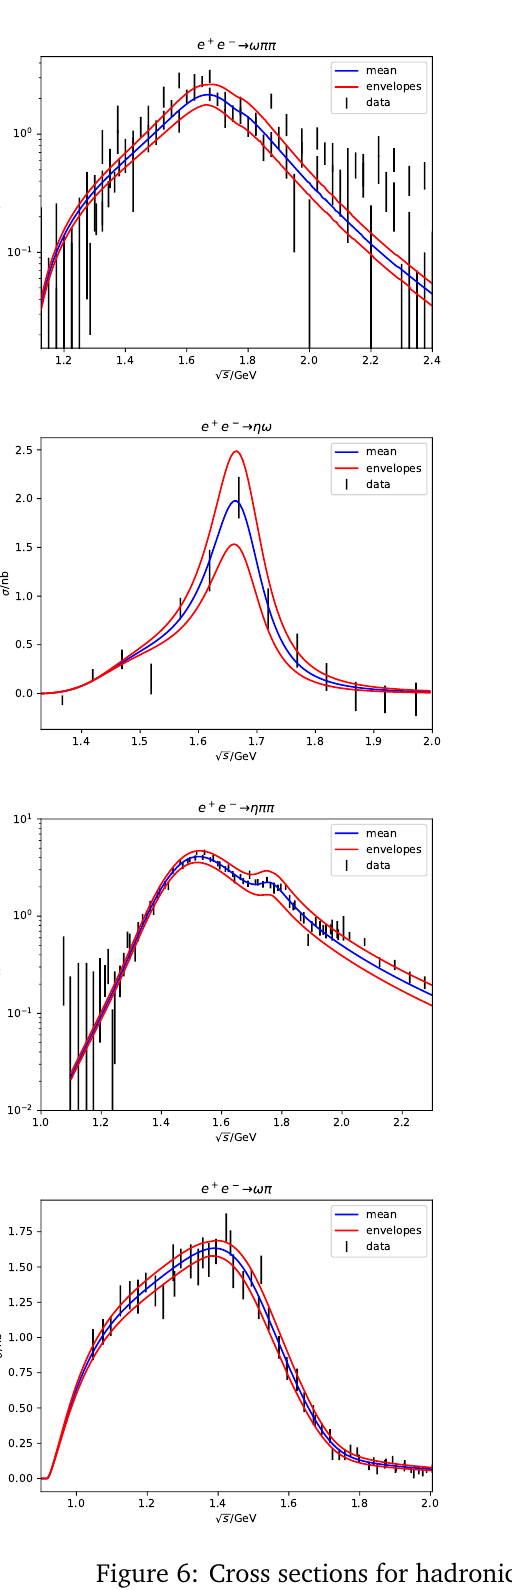
Figure 6: Cross sections for hadronic final states with error